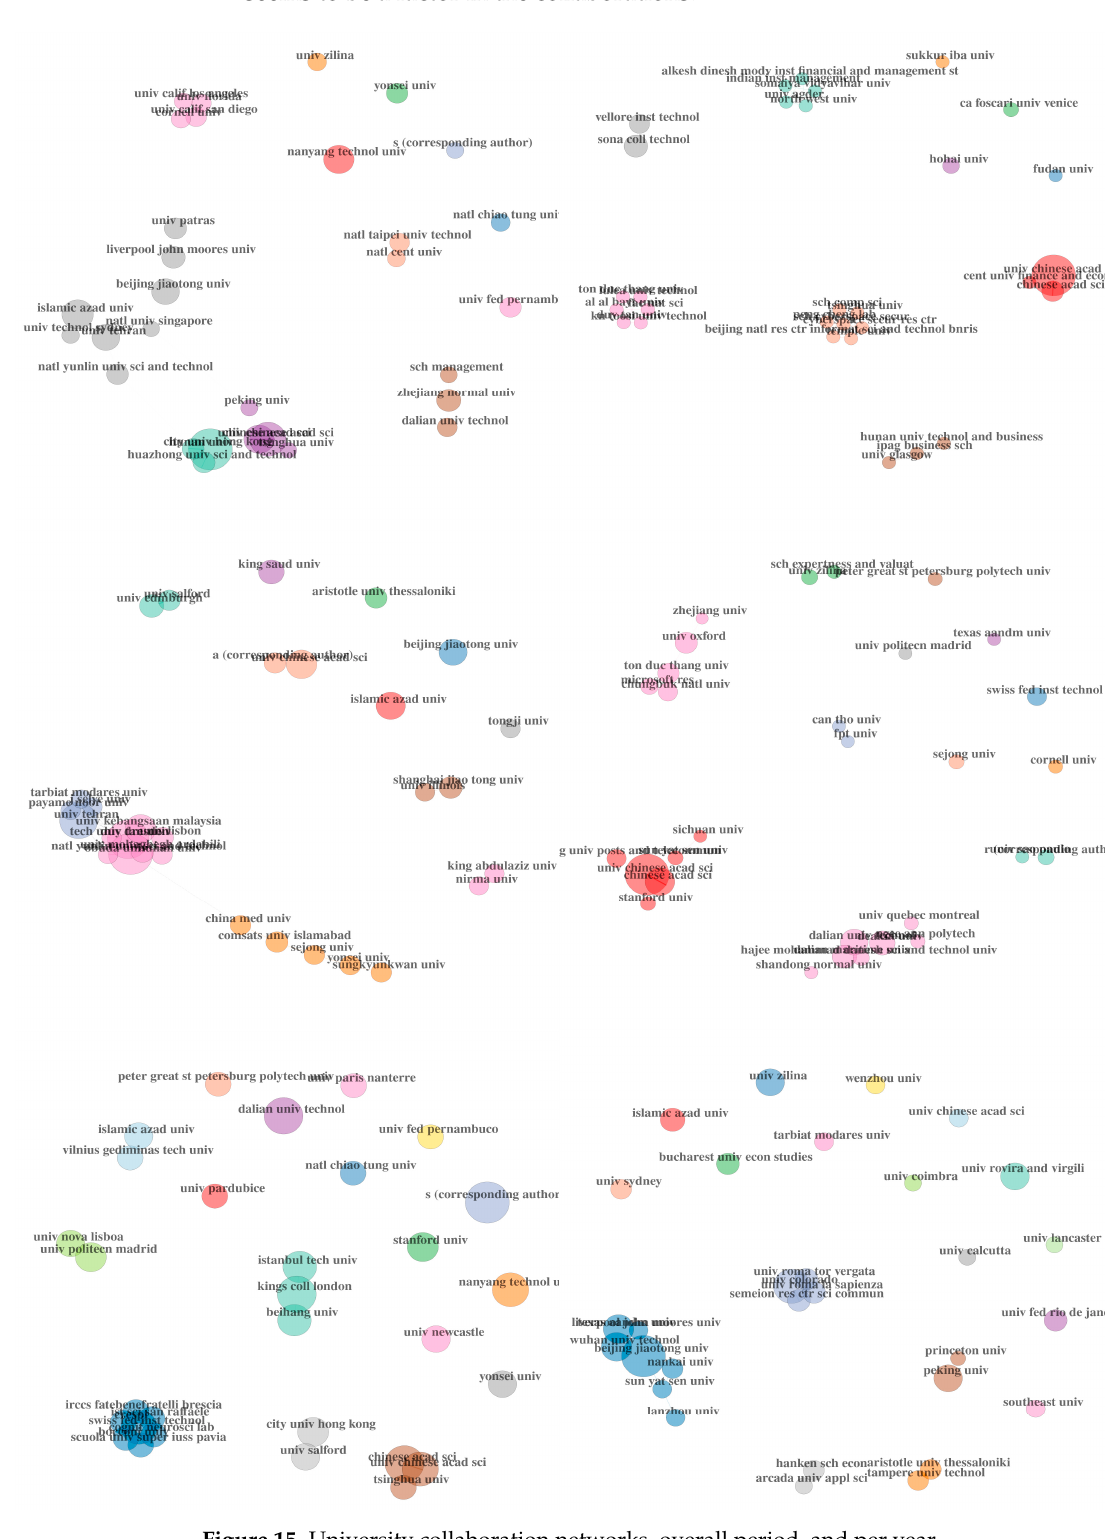
Figure 15. University collaboration networks, overall period, and per year.